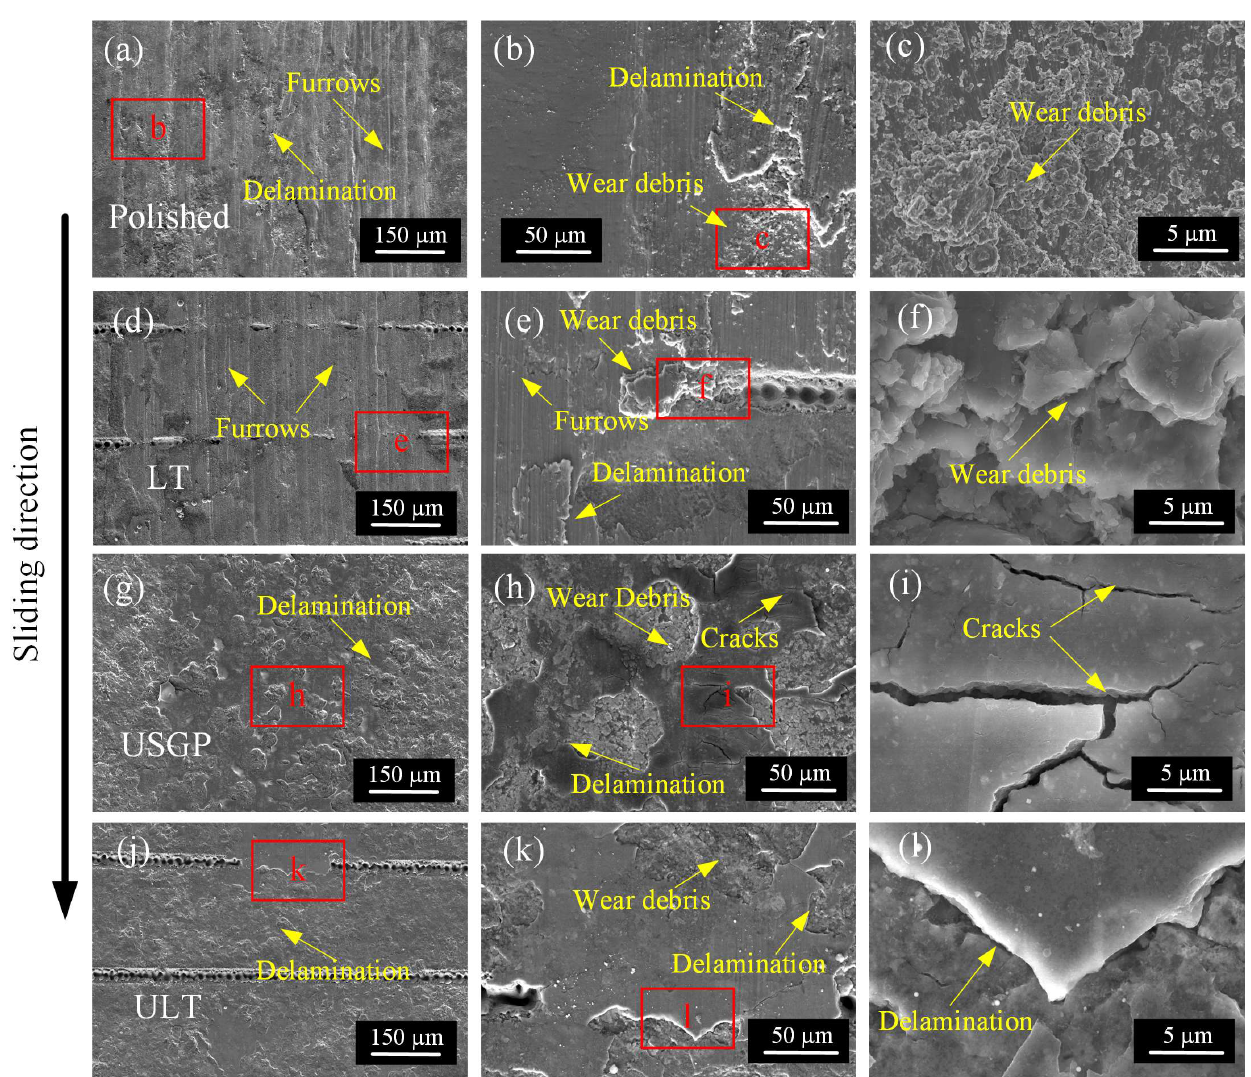
Figure 9. The worn surface morphologies of the polished ( a – c ), LT ( d – f ), USGP ( g – i ), and ULT ( j – l ) samples after sliding under a fixed normal load of 15 N for 3600 s at a constant sliding velocity of 30 mm/s. The figures ( b , e , h , k ) are the enlarged images of the areas with red letters in figure ( a , d , g , j ), and figures ( c , f , i , l ) are the enlarged appearances of the areas with red letters in figure ( b , e , h , k ), respectively.